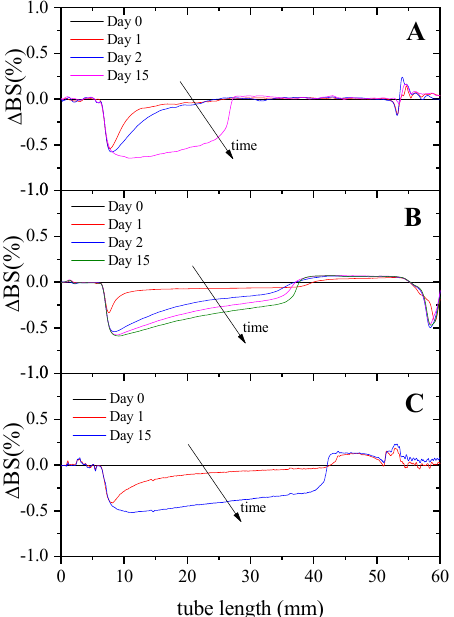
Figure 4. Changes in backscattering profiles (DBS%) as a function of sample height with storage time of W 1 /O/W 2 multiple emulsions obtained after three different O/W ratios for the secondary emulsion: 40/60 ( A ), 25/75 ( B ) and 10/90 ( C ). The arrows indicate the storage time.